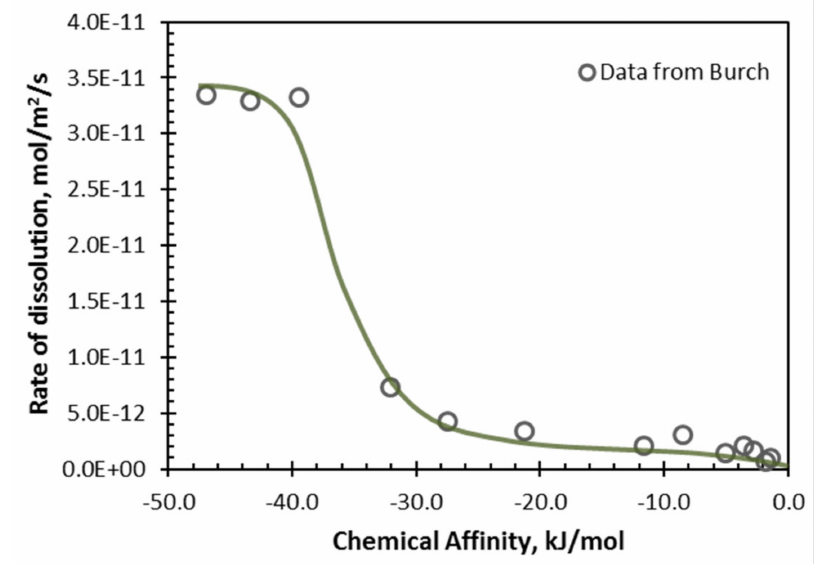
Figure 10. The dissolution of albite, NaAlSi 3 O 8 , as a function of chemical affinity at 80 ◦ C and pH 8.8. The line represents the surface-vacancy model. Data from Burch et al. [76]. Model from Crundwell